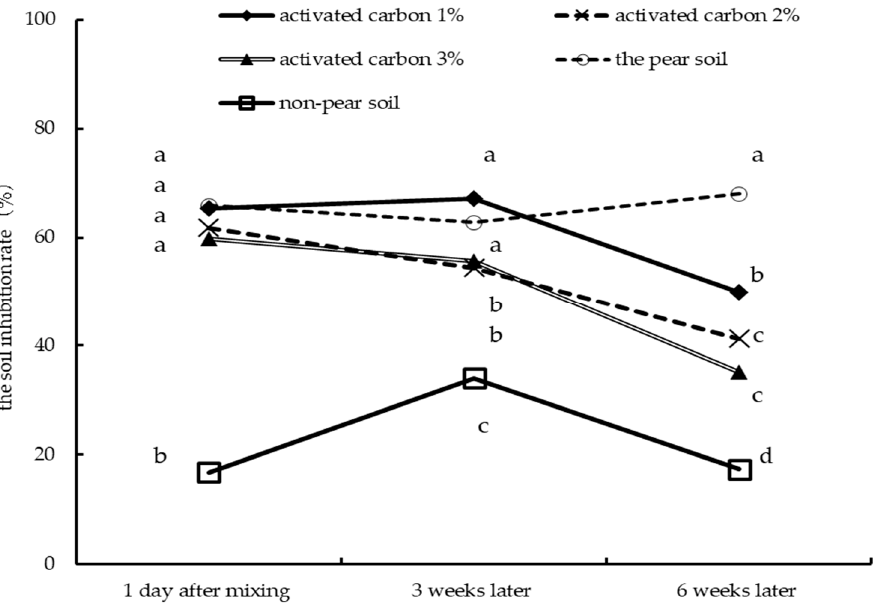
Figure 2. Transition of the inhibition rate of soil mixed with activated carbon. Data were analyzed by Tukey–Kramer method after arcsine transformation. Different letters indicate a significant difference at the 5% level.